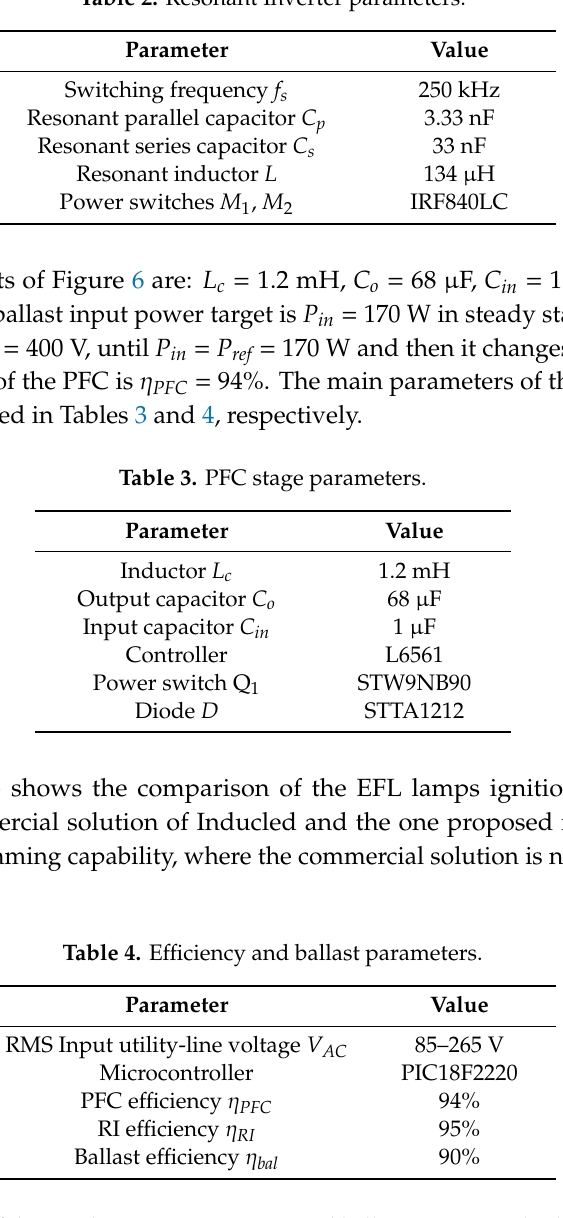
Table 5. Comparison of the EFL lamps ignition: proposed ballast, commercial solution of Inducled and ballasts in